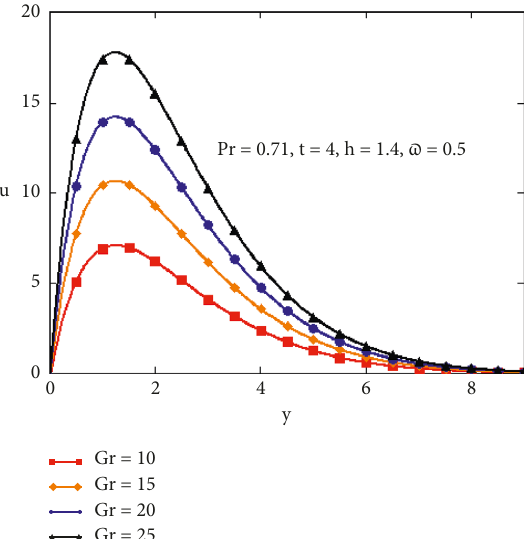
Figure 1: Velocity profile for different values of Gr.